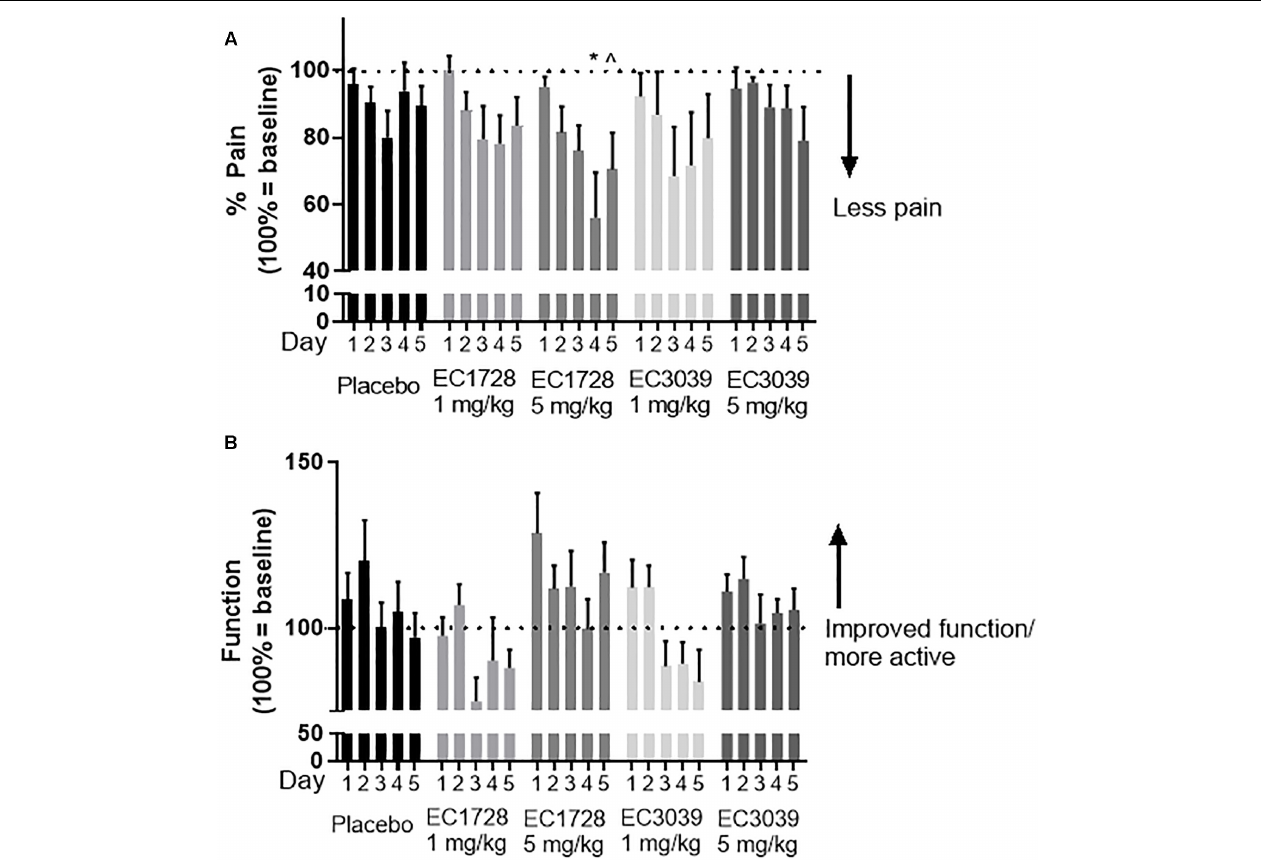
FIGURE 3 | EC1728 at 5 mg/kg reduced pain and increased function in dogs with osteoarthritis (OA). In order to assess pain, technicians blinded to treatment answered a predetermined questionnaire based on observed dog behavior (on a scale of 0–2), and activity (on a scale of 0–5) of aged beagle dogs. Score 0 was classified as least pain and most function. The composite score was normalized for each individual dog to their predose score for pain (A) and function (B) are presented. (A) Dogs treated orally, once daily with EC1728 at 5 mg/kg for 5 days had significantly less pain compared to the placebo group. Placebo control consisted of administration of an empty 100% PEG300, and size 12 capsules from Torpac. Statistical significance was reached on day 4. After 5-days of dosing, EC1728 significantly reduced pain compared to vehicle control when analyzed by repeated measures ANOVA. There were no statistical differences identified for other treatment groups. (B) While no statistical significance was observed for improvement in function with any treatment group, dogs treated with EC1728 tended to have higher function scores than other treatment groups ( p < 0.05 for treatment effect when analyzed by repeated measures ANOVA, but there was no statistically significant interaction between treatment groups). ∗ p < 0.05 compared to placebo and ∧ p < 0.05 for cummulative treatment effects when analyzed by repeated measure